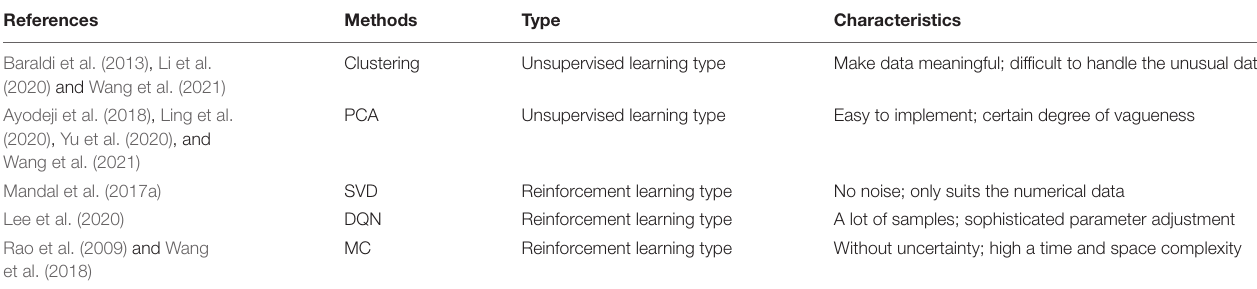
TABLE 2 | Status of the data-driven machine learning (DDML) of the unsupervised and reinforcement learning method for the fault diagnosis and detection (FDD) in the nuclear power plant